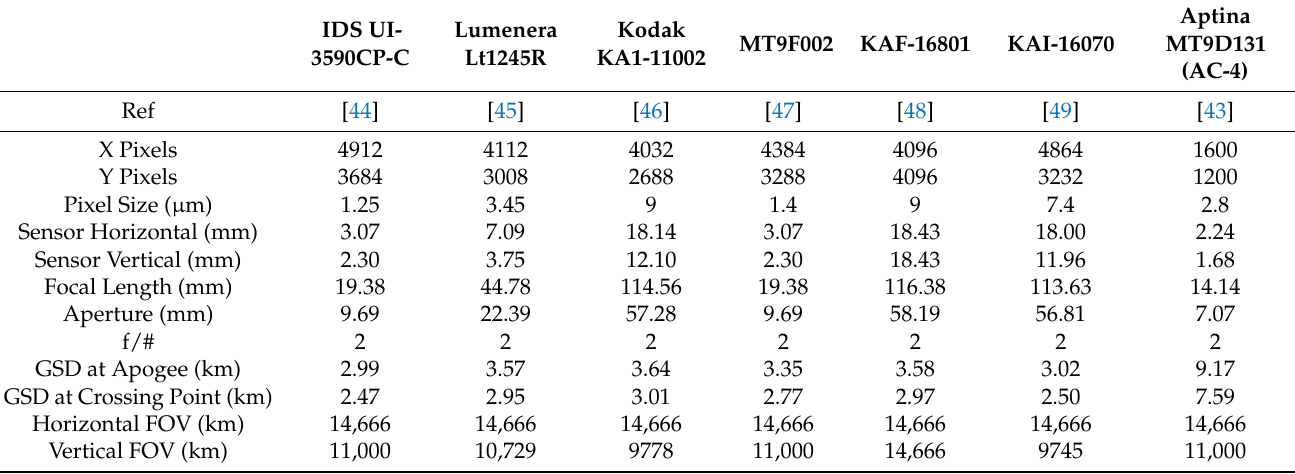
Table 4. Sensor specifications of 4K sensors and their calculated optics parameters for a 18 ◦ FOV in Tundra orbit. The AC-4 Megapixel sensor (Aptina MT9D131 [26]) is also included for